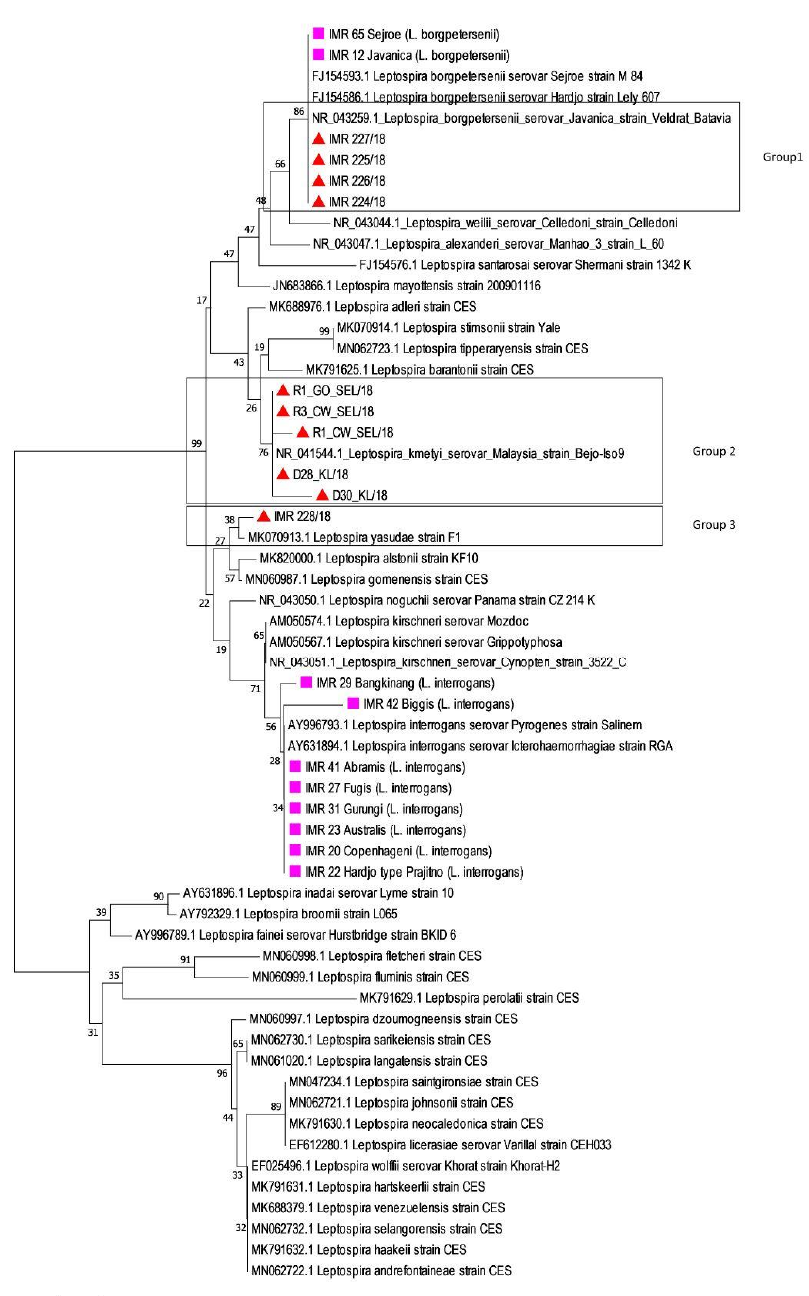
Figure 2. Genetic relatedness comparing strains from rodents, dogs and soil samples ( ) to old reference Malaysian Leptospira isolates ( ) and NCBI reference strains based on rrs2 genes using neighbor-joining phylogenetic trees with bootstraps of 100.